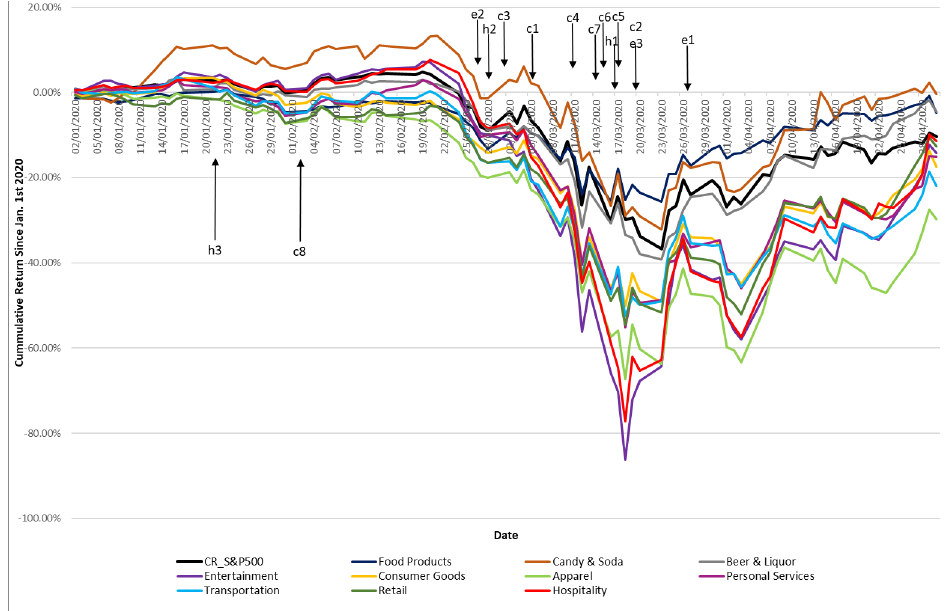
Fig 1. Comparison of the cumulative returns of the S&P 500, the hospitality industry and its related industries indexes A . The figure depicts the cumulative returns of the S&P 500, the hospitality industry and the indices of numerous related industries since the outbreak of COVID-19 in January 2020. “c,” “e” and “h” denote closures, economic and health measures,